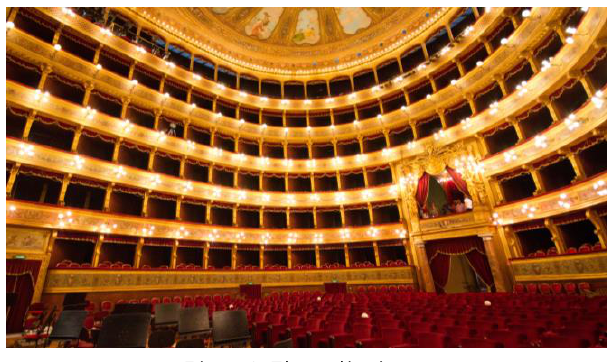
Figure 3. The auditorium